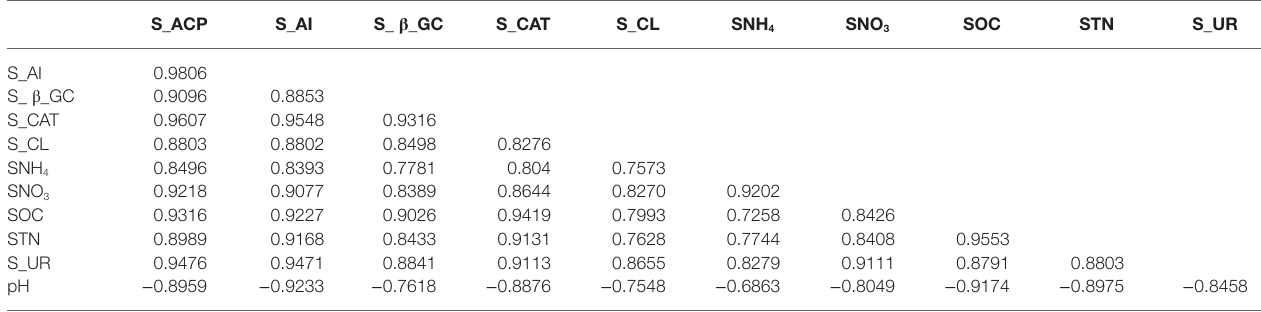
TABLE 2 | Pearson’s correlation analysis for soil enzymes and physio-chemical properties.